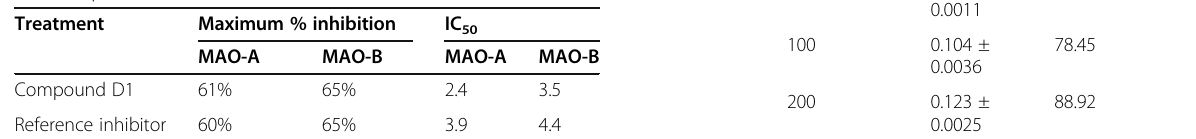
Table 4 IC 50 value for the inhibition of MAO-A and MAO-B by the compound D1 and reference inhibitor